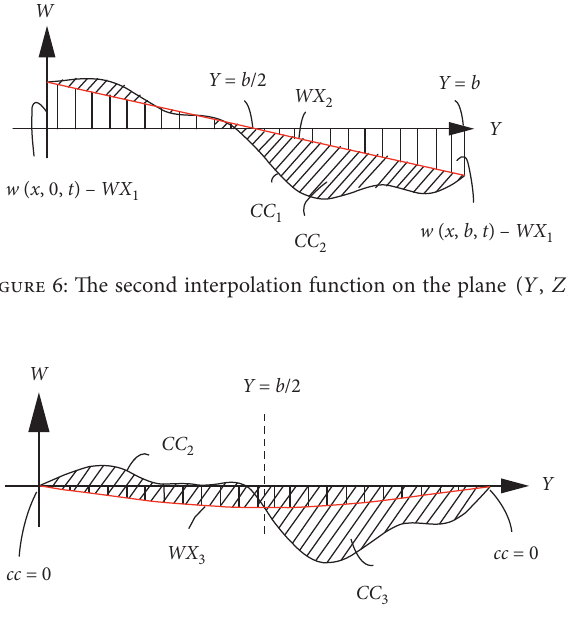
Figure 7: The third interpolation function on the plane ( Y, Z ) .